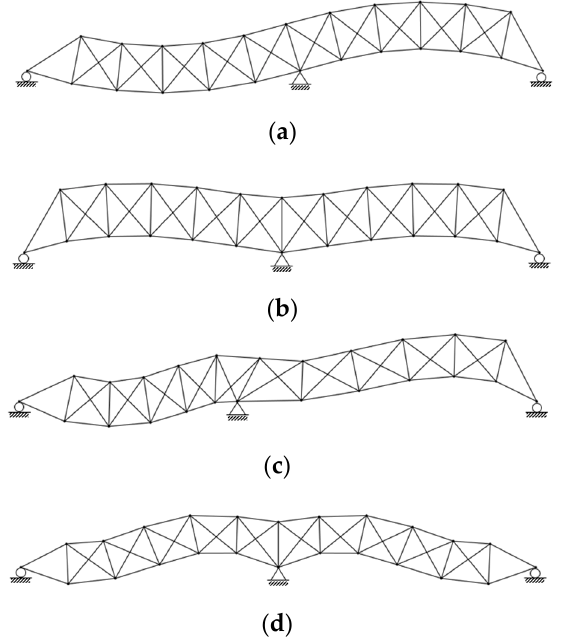
Figure 11. Examples of MSF derived by frequency analysis (truss): ( a ) MSF1, ( b ) MSF2, ( c ) MSF3, ( d ) MDF3.